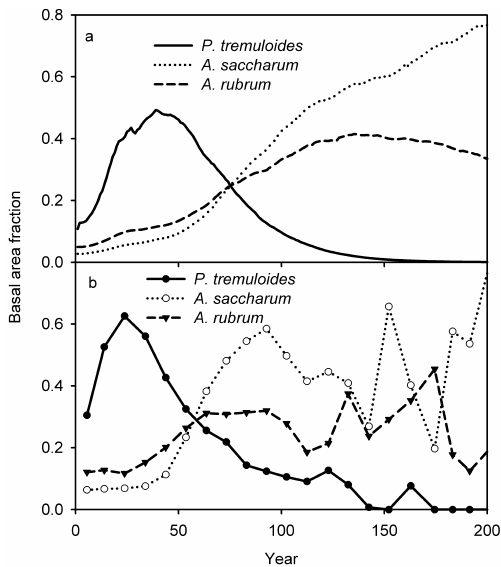
Figure 4. Forest succession. Panel (a) shows simulated forest suc- cession for three species ( Populus tremuloides , Acer saccharum , and A. rubrum ), with parameters and initial densities in Table 1. Panel (b) shows the successional dynamics estimated from FIA in- ventory data in the northern lake states, USA. The basal areas of the three species are normalized relative to the maximum of their summed basal areas because the three species in the model runs ac- count for only approximately one-half of the total basal area in the data. This normalization only changes the y -axis scale. The non- normalized predictions and data are in Fig. S5.